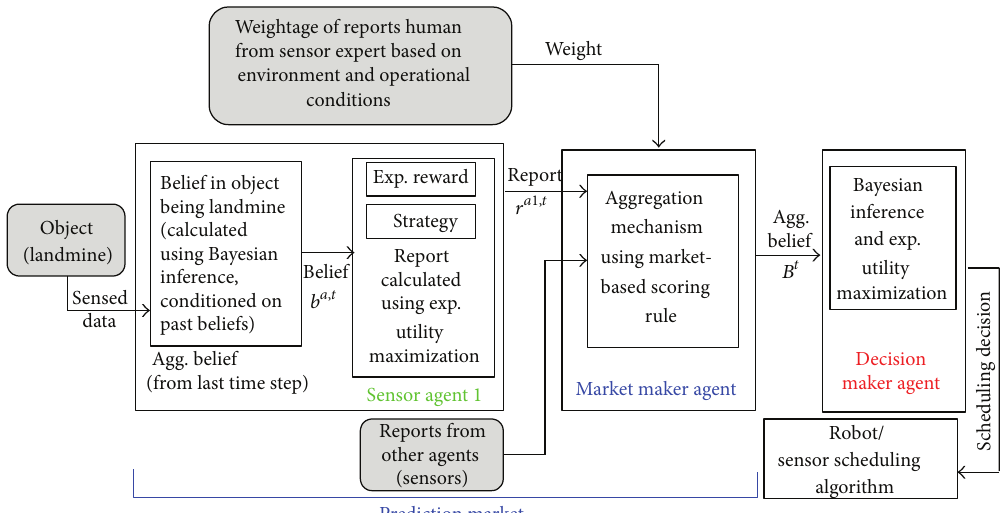
Figure 11: Weightage of sensor reports from human expert based on environment and operational conditions.